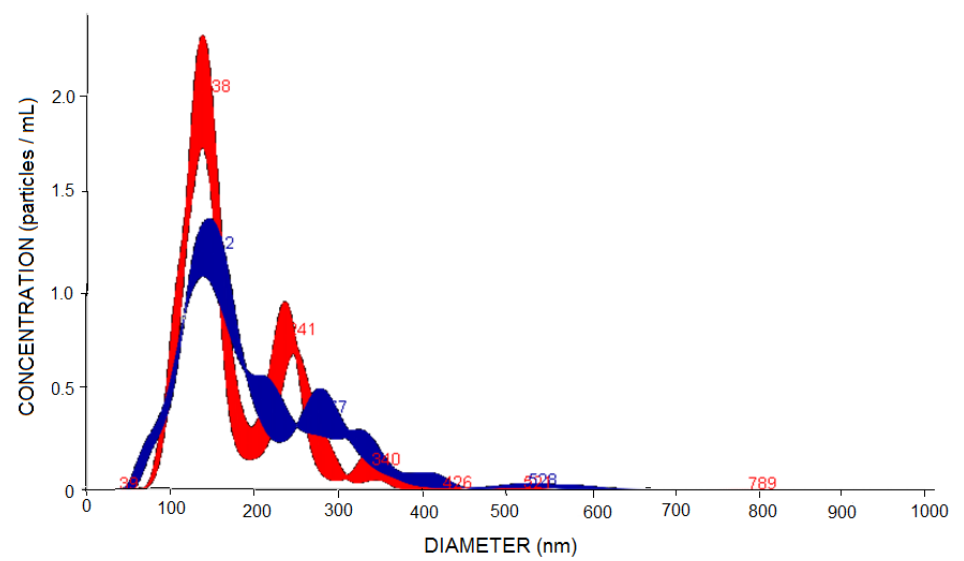
Figure 4. Distribution of PN’s size by concentration analyzed by NTA: EMP-PN (red) and PG-PN (blue).